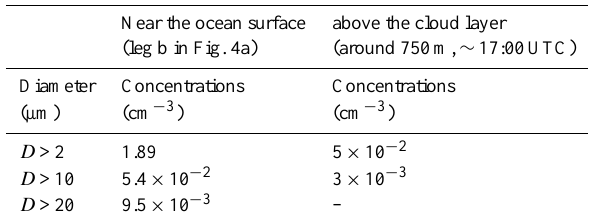
Table 1. GCCN concentrations obtained from CAS on 3 August